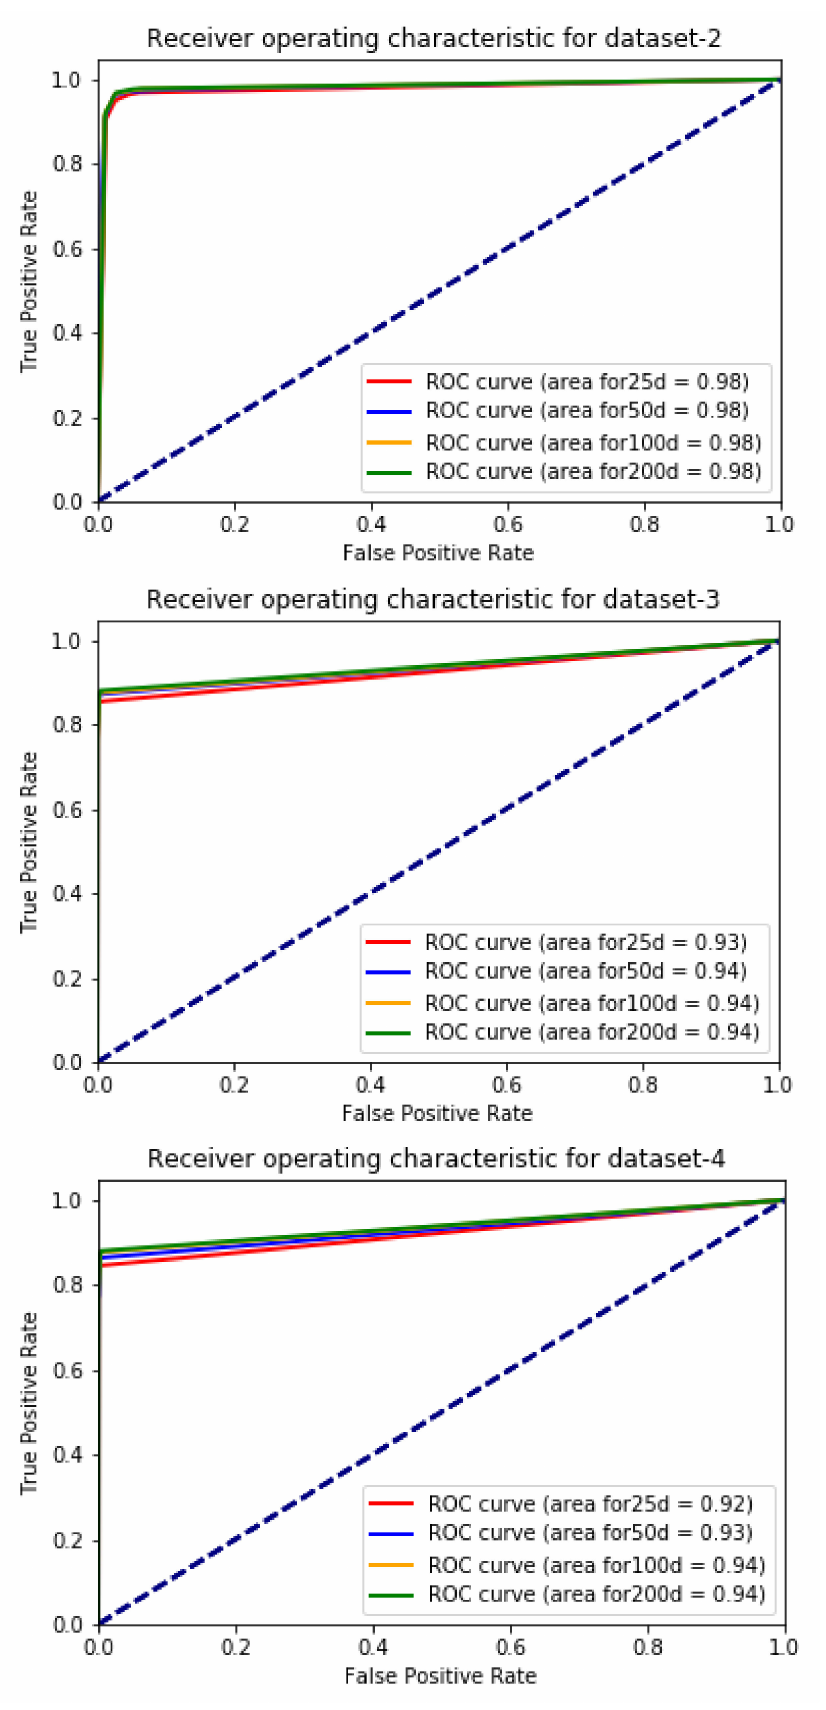
Figure 12. ROC curve for the results of our proposed framework for different datasets 1, 2, 3, and